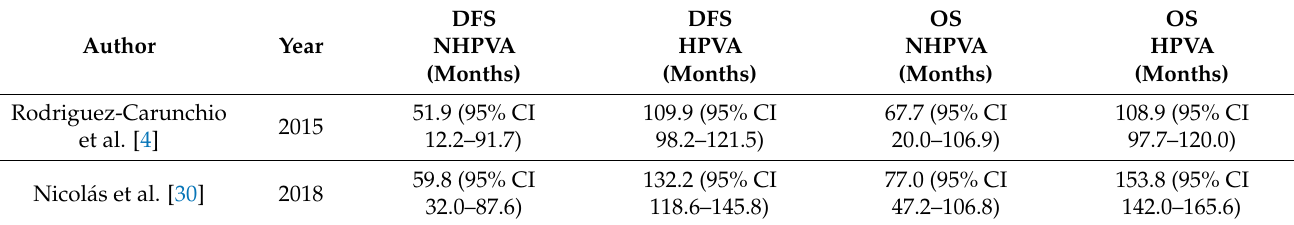
Table 6. Disease-free survival and overall survival in different non-human papillomavirus-associated adenocarcinoma and human papillomavirus-associated adenocarcinoma